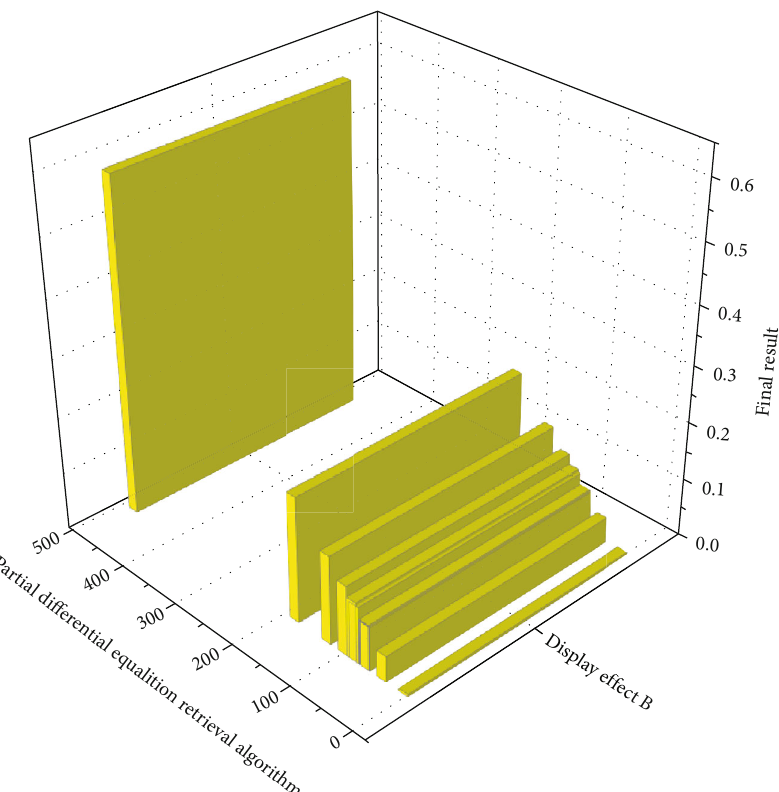
Figure 5: Neural network training e ff ect graph.